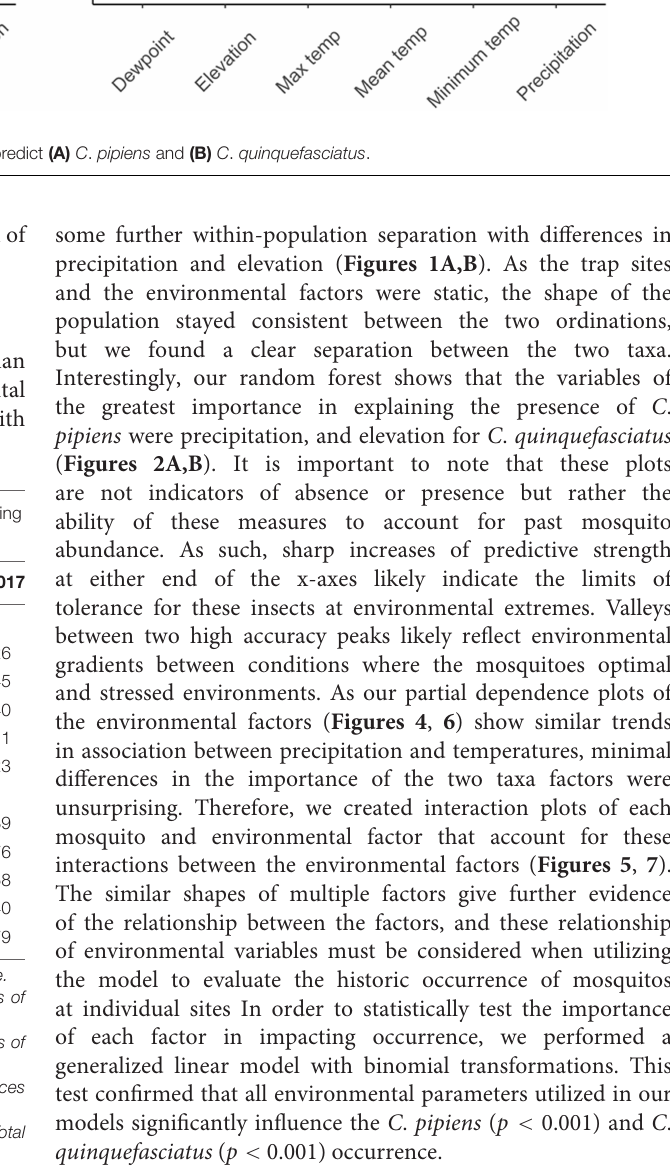
FIGURE 2 | Graphs depicting most important environmental parameters to predict (A) C . pipiens and (B) C . quinquefasciatus .